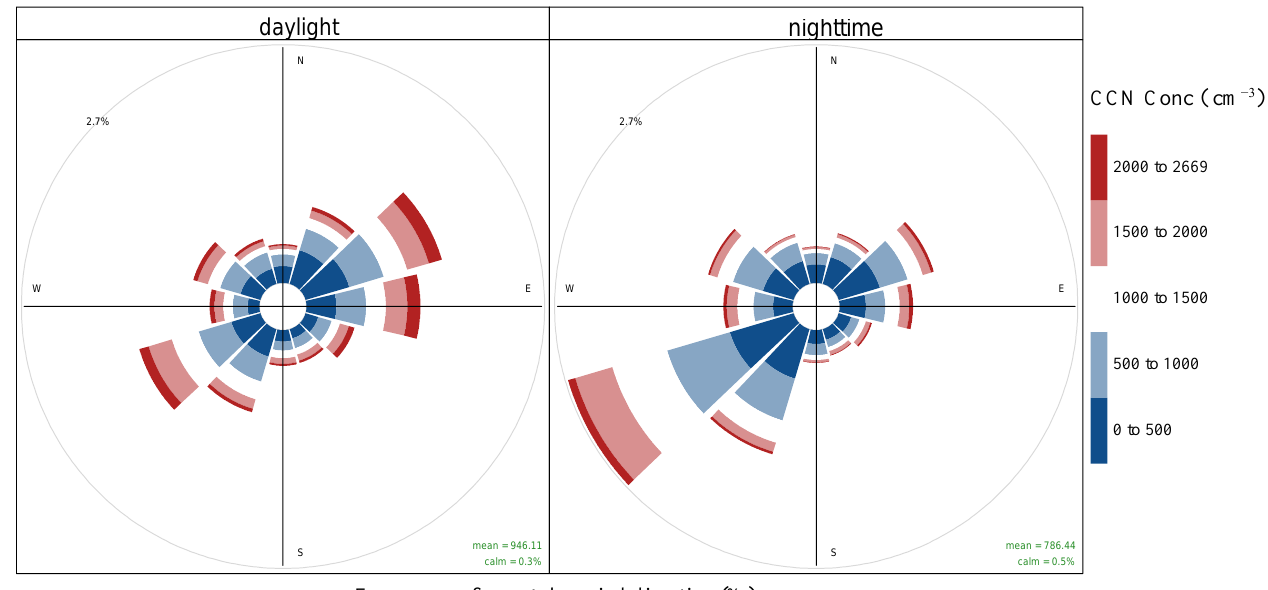
Figure 7. Contribution of four seasonal wind directions to CCN concentration.